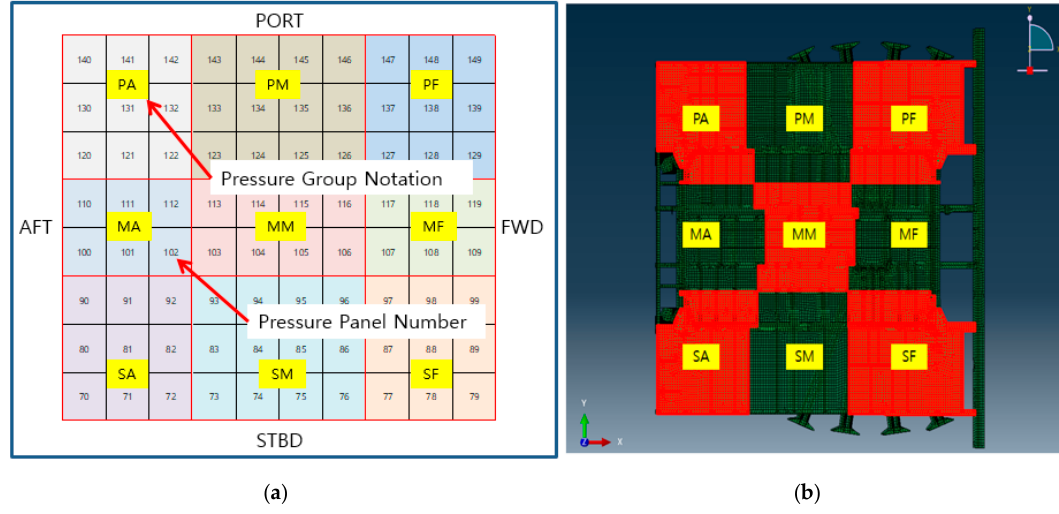
Figure 9. ( a ) Pressure group configuration in FLACS explosion model and ( b ) pressure application on finite element (FE) model.